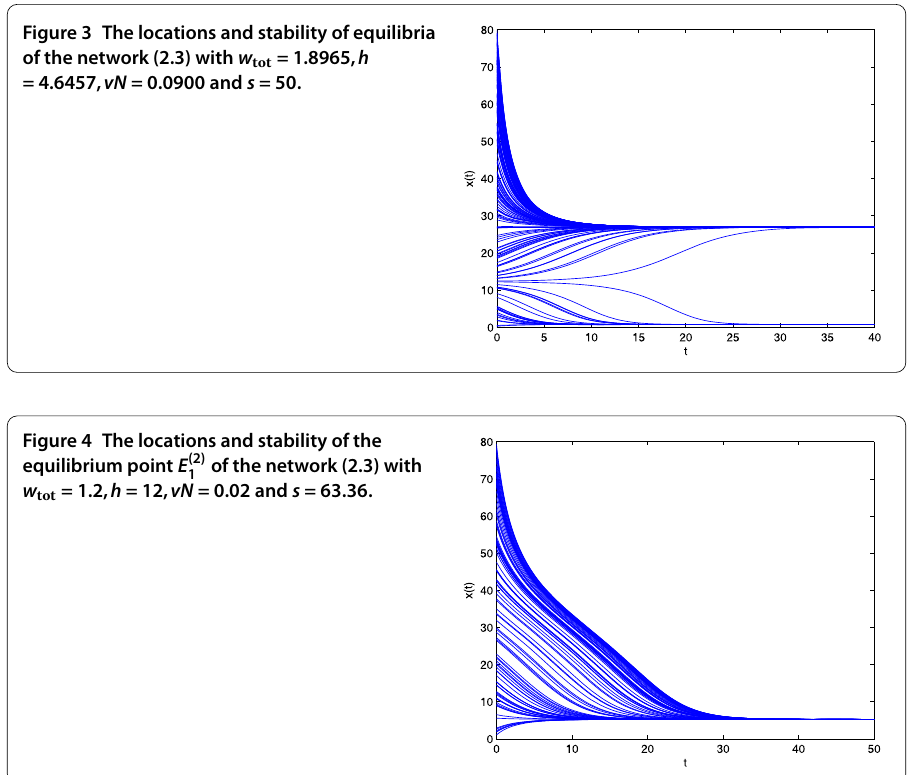
Figure 3 The locations and stability of equilibria of the network (2.3) with w tot = 1.8965, h = 4.6457, vN = 0.0900 and s = 50.